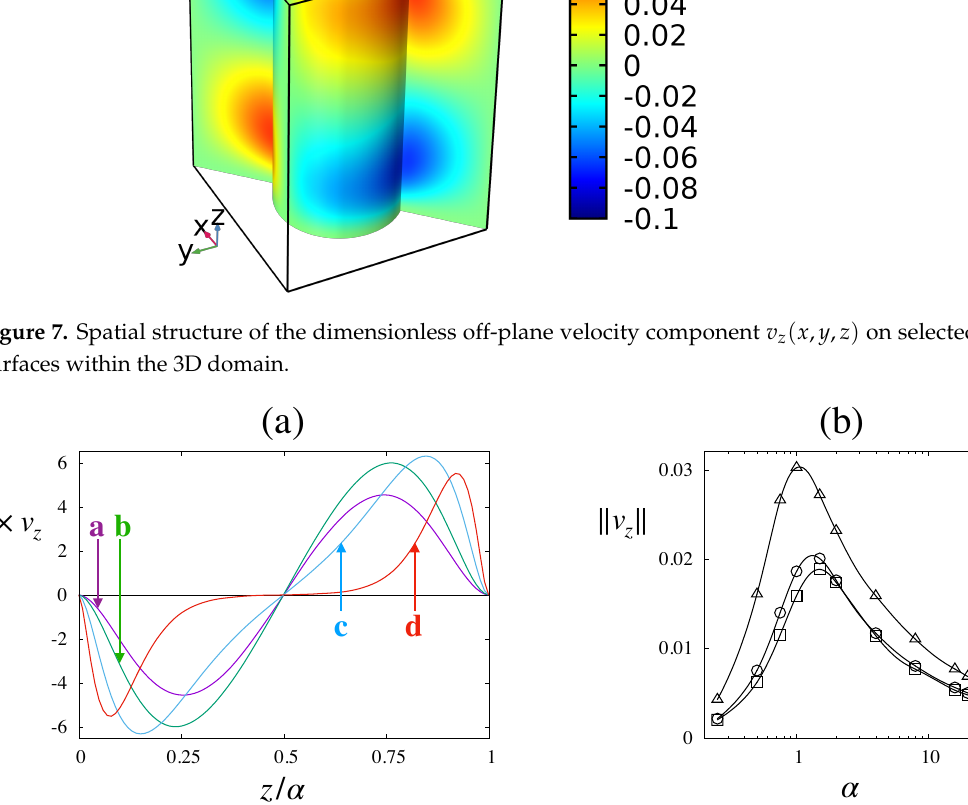
Figure 8. Panel ( a ): Profiles of the off plane velocity component v z ( x , y , z ) (scaled to the average cell velocity) vs z / α along a vertical line ( x = 1/4, y = 1/4). Lines a, b, c and d represent cell geometries with α = 3/4; 1; 2; 4, respectively and fixed (dimensionless) obstacle diameter, d o = 0.4. Panel ( b ) depicts the L 2 -norm of v z in Ω vs the cell aspect ratio α for different diameters of the cylindrical obstacles; square symbols: d o = 0.4; circles: d o = 0.6; triangles: d o =